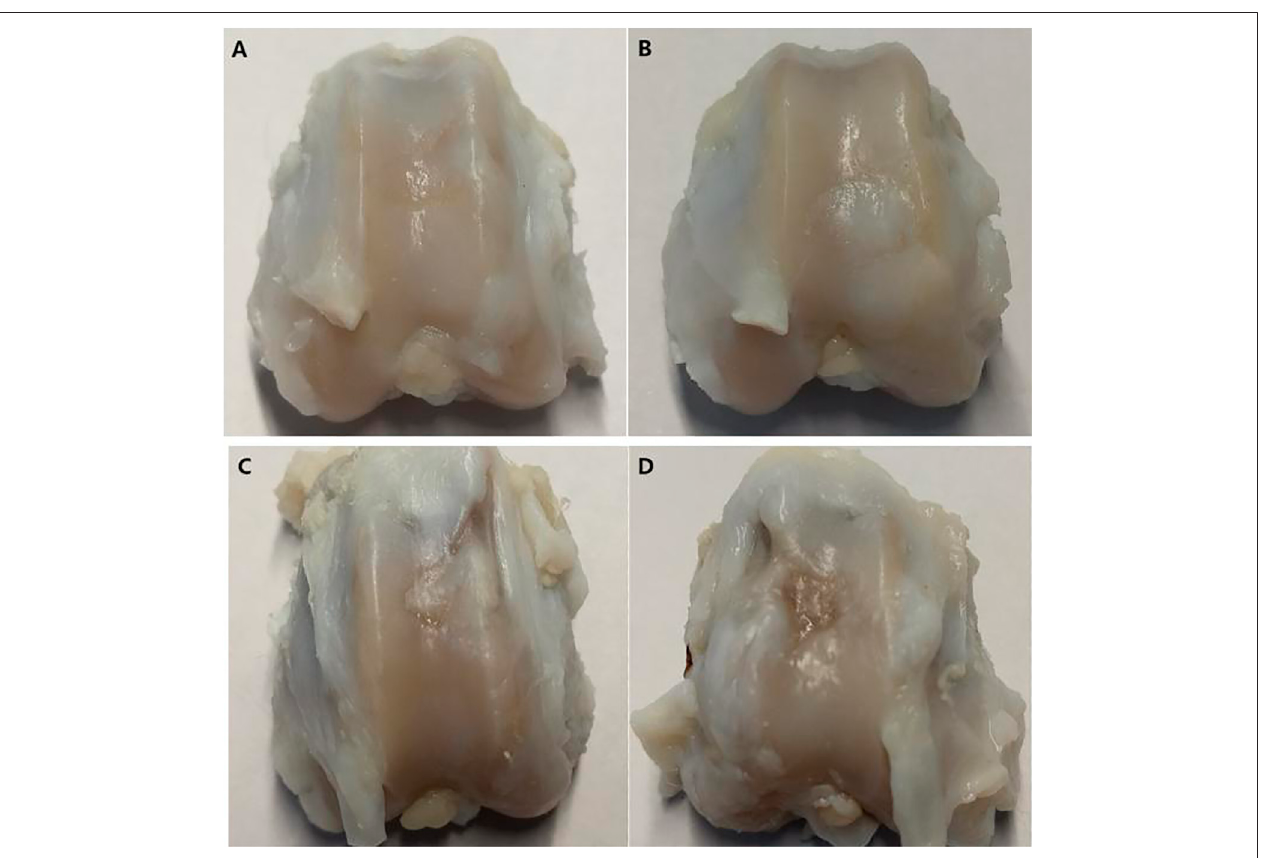
FIGURE 8 | Gross views of four groups of specimens taken at 12 weeks after